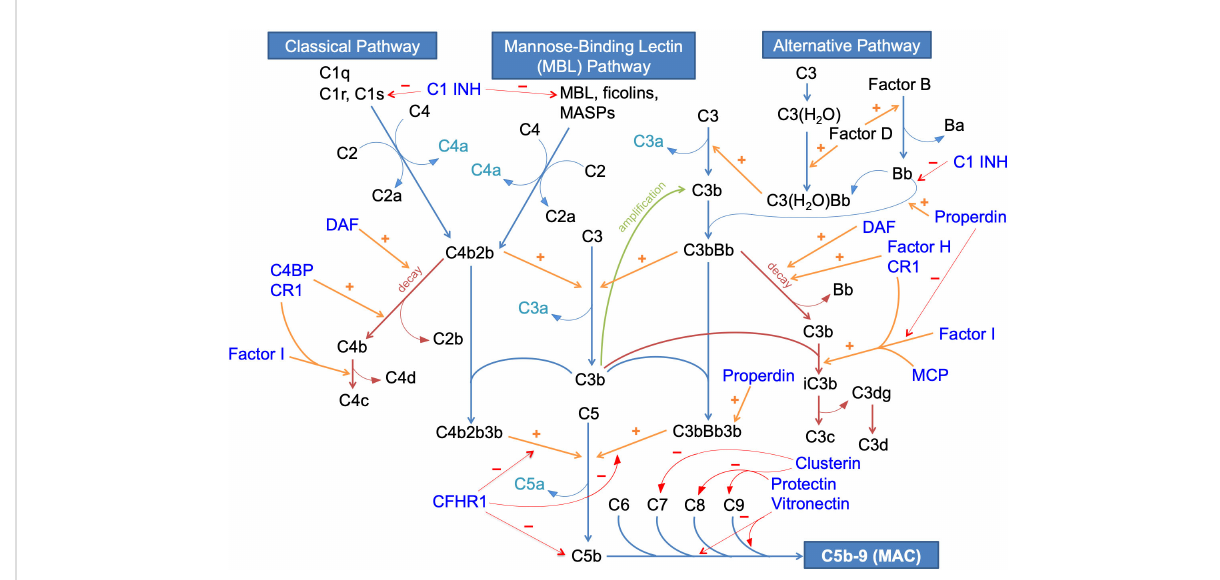
FIGURE 1 The complement system in humans. C1 INH, C1 inhibitor; C4BP, C4 binding protein; CFHR1, complement factor H-related protein 1; CR1, complement receptor 1; DAF: decay accelerating factor; MAC, membrane attack complex; MASPs, mannose-binding lectin-associated serine proteases; MBL, mannose-binding lectin; MCP, membrane cofactor protein; ampli fi cation pathways are shown in green; decay pathways are shown in maroon; inhibitory pathways are shown in red; stimulatory/catalytic pathways are shown in orange; complement regulatory proteins (CRPs) are shown in indigo; anaphylatoxins are shown in cyan; all other complements and related products are shown in